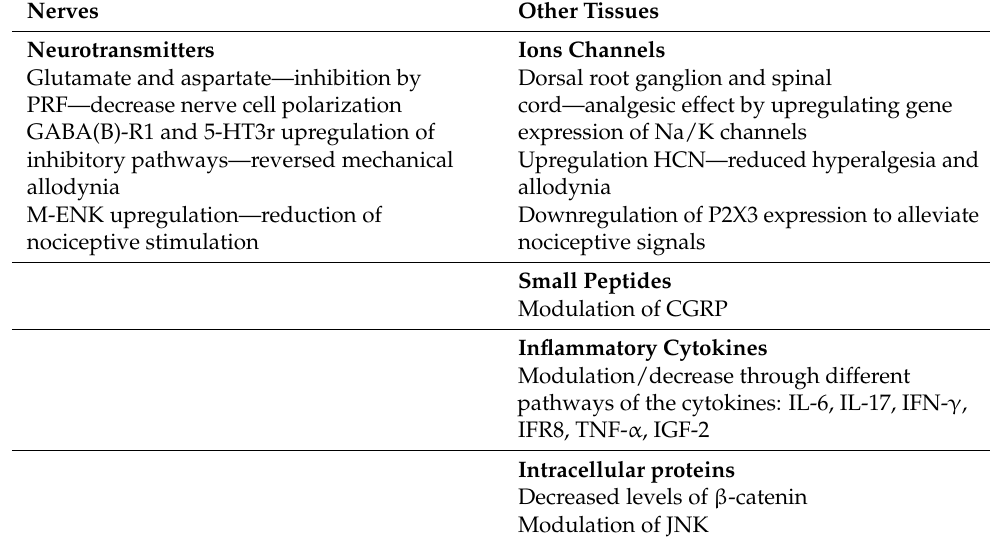
Table 1. Analgesic effects of PRF related to nerves and other tissues and its mechanisms